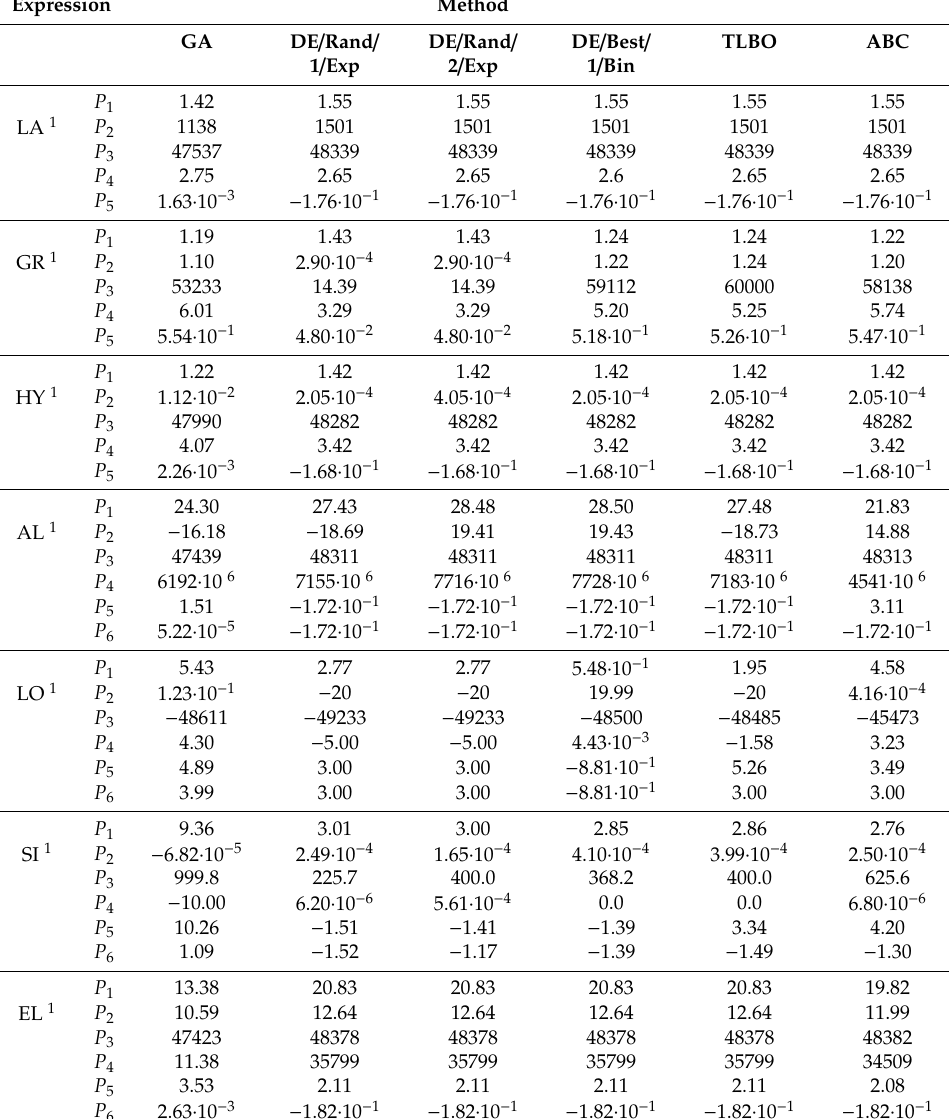
Table 5. Parameters of expressions for the results (best OF) from Table 3 for